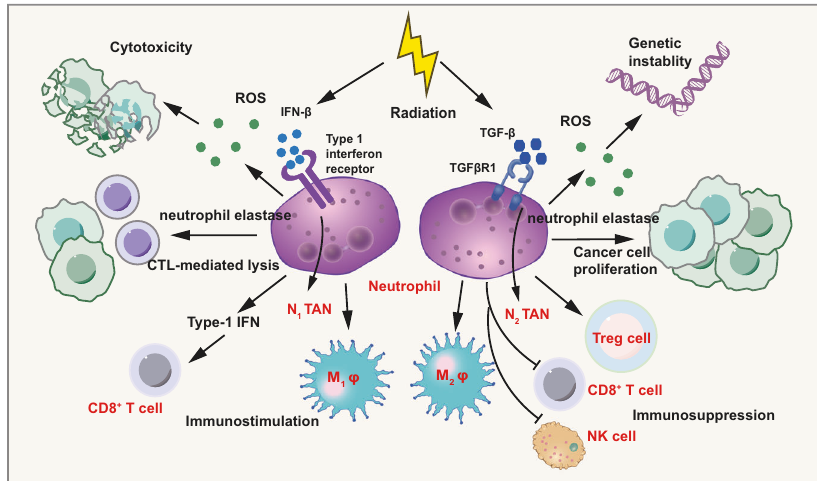
Fig. 3 Immunomodulatory effect of radiation on TANs. Radiation shows complexity regarding the immunomodulatory effect on TANs. On the one hand, radiation may induce TANs to exhibit the antitumor characteristic (N1) by IFN- β . N1 phenotype induces tumor cells cytotoxicity/ apoptosis through ROS and activates CD8 + T cells and M1 macrophage. On the other hand, radiation may induce TANs to exhibit the pro- tumor characteristic through TGF- β . N2 phenotype promotes genetic instability by ROS, cancer proliferation, and immunosuppression effect by inhibiting CD8 + T cells and NK cells and enhancing Treg cells. Parts of this fi gure were drawn with aid of Servier Medical Art (http:// www.servier.com), licensed under a Creative Commons Attribution 3.0 Unported